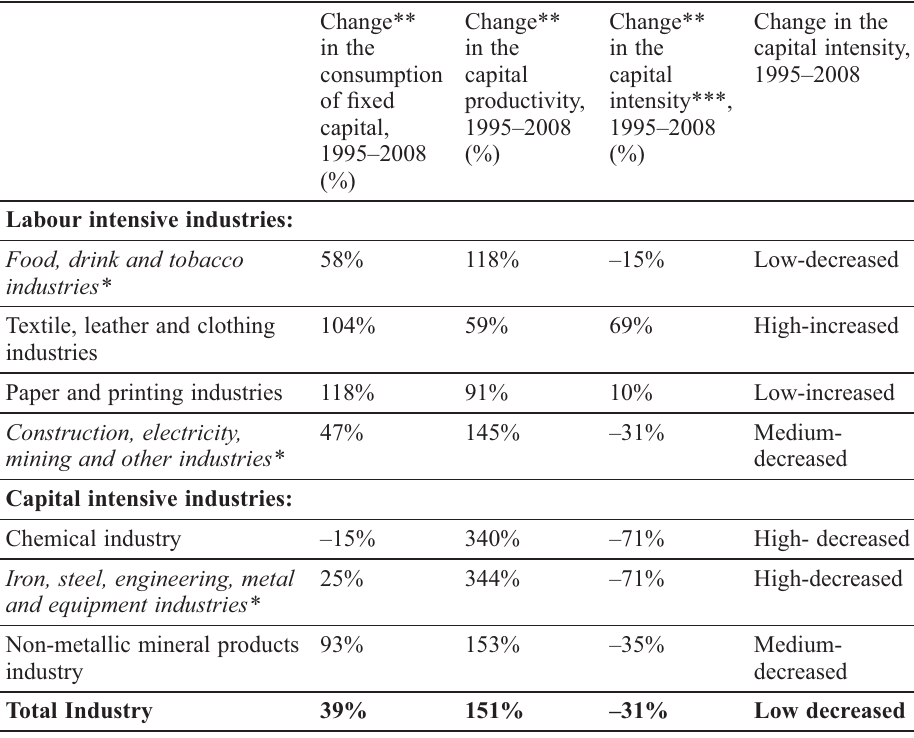
Table 2. Percentage change in the capital as factors of production use in Lithuanian industry during the 1995–2008